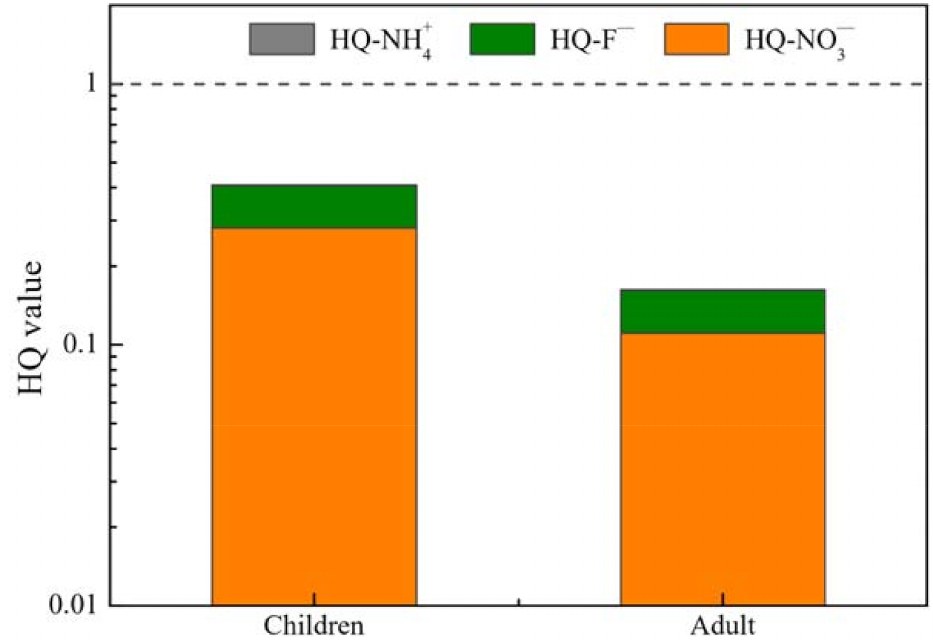
Figure 7. Non–carcinogenic health risk assessment of fluorine, nitrate, ammonia in Chishui River